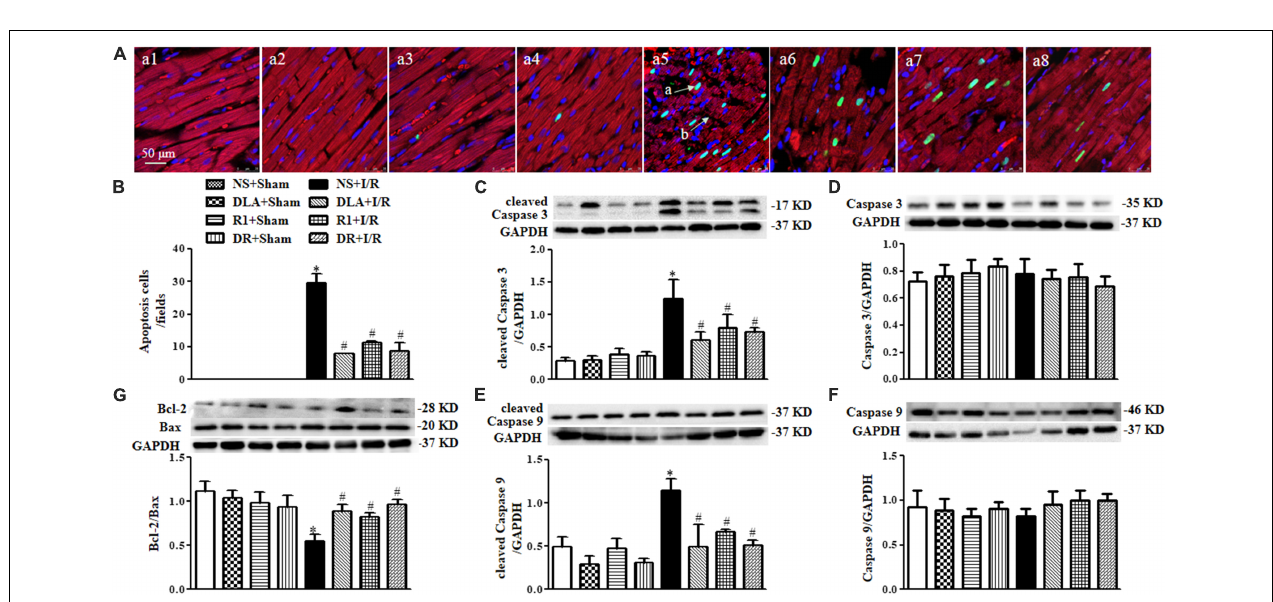
FIGURE 6 | The effect of DLA, R1, and DR pretreatment on myocardial apoptosis and filamentous actin (F-actin) structure in rats after I/R for 90 min. (A) Examples of myocardium photographs showing F-actin and TUNEL-positive apoptotic cells in the NS + Sham group (a1) , the DLA + Sham group (a2) , the R1 + Sham group (a3) , the DR + Sham group (a4) , the NS + I/R group (a5) , the DLA + I/R group (a6) , the R1 + I/R group (a7), and the DR + I/R group (a8) . Nuclei are stained as blue, F-actin red, and terminal deoxynucleotidyl transferase-mediated dUTP-biotin nick end-labeling (TUNEL)-positive cells green ( arrow a : TUNEL-positive cell; arrow b : disrupture of F-actin). Bar = 50 µ m. (B) Quantitative assessment of apoptotic cardiomyocytes in various conditions. (C) Examples of Western blot bands and densitometric values of cleaved Caspase 3 corrected for GAPDH. (D) Examples of Western blot bands and densitometric values of Caspase 3 corrected for GAPDH. (E) Examples of Western blot bands and densitometric values of cleaved Caspase 9 corrected for GAPDH. (F) Examples of Western blot bands and densitometric values of Caspase 9 corrected for GAPDH. (G) Western blot result of Bcl-2/Bax in the myocardium ( n = 6). Data are expressed as means ± SEM (n = 6). * p < 0.05 vs. NS + Sham group; # p < 0.05 vs. NS + I/R